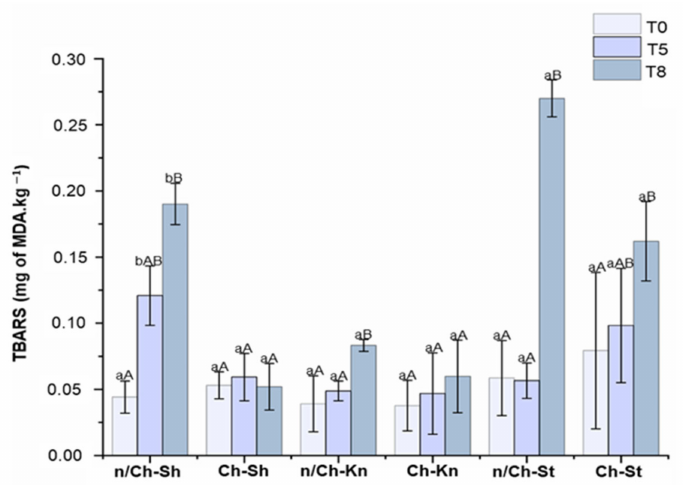
Figure 6. Thiobarbituric acid-reactive substances (TBARS) (mg of malonaldehyde (MDA)/kg of meat) of vacuum-packed beef cut samples (non-coated and coated) over the storage period of 0 (T0), 5 (T5) and 8 (T8) days at 4 ◦ C. n/Ch–Sh = non-coated shoulder; Ch–Sh = coated shoulder; n/Ch–St = non-coated striploin; Ch–St = coated striploin; n/Ch–Kn = non-coated knuckle; Ch–Kn = coated knuckle. Columns represent the mean ( n = 3), and the bars represent the standard deviation. a,b Different lower case letters show significant differences ( p < 0.05) between the same beef cut with different treatments on the same storage day. A,B Different uppercase letters indicate significant differences ( p < 0.05) for the same beef cut sample over the storage period (T0, T5 and